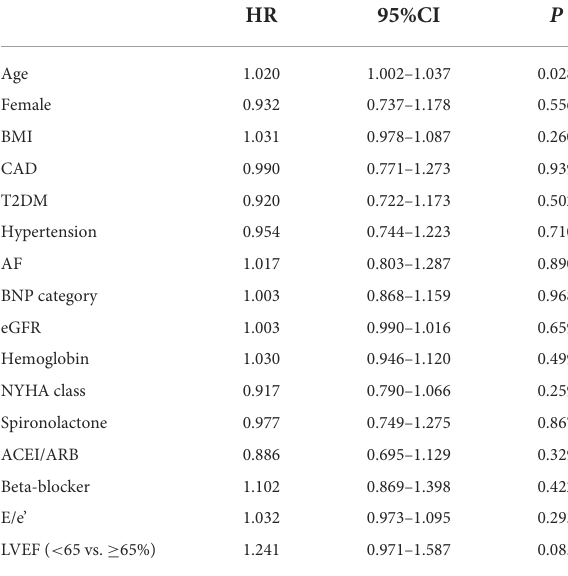
TABLE 6 Multivariable Cox analysis for all-cause mortality in HFpEF patients with LVEF ≥ 60%.